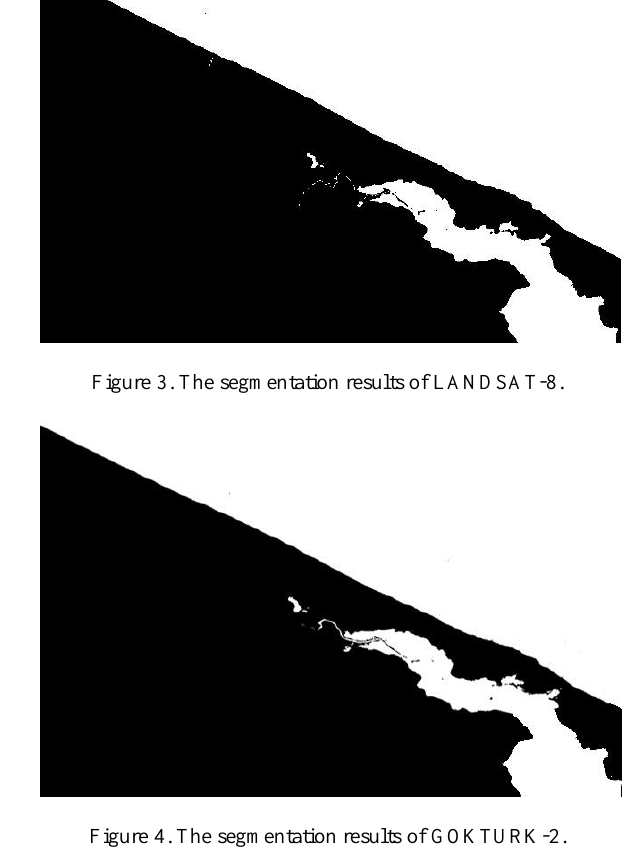
Figure 4. The segmentation results of